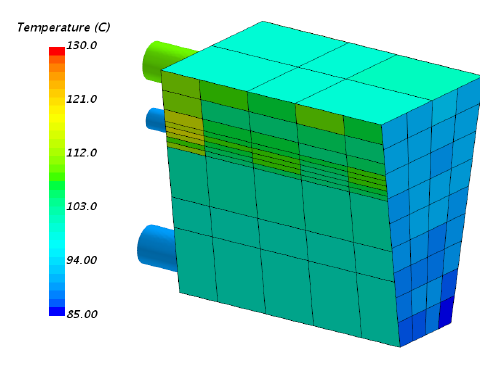
Figure 6. Boundary condition for temperature distribution across the engine surfaces used in the standalone CFD simulation. The presented temperature distribution is obtained from measurements during steady mode of heat